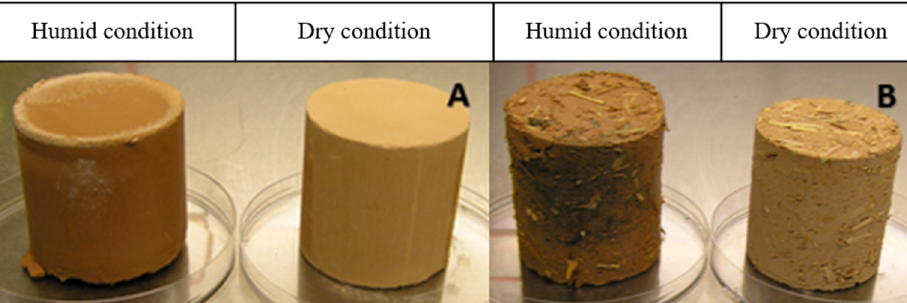
Figure 6. FWAS‐S0% (A) and FWAS‐S3% (B) specimens observations after an incubation at room temperature under humid condition (specimen on the left) or dry condition (specimen on the